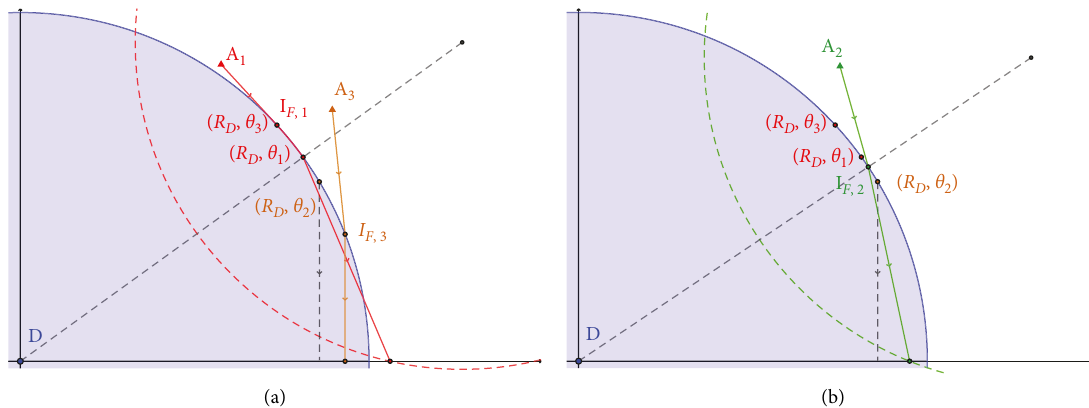
����� √ ( 1 − α 2 . (a) The optimal trajectories when the attacker’s / α ) y D, D > 0